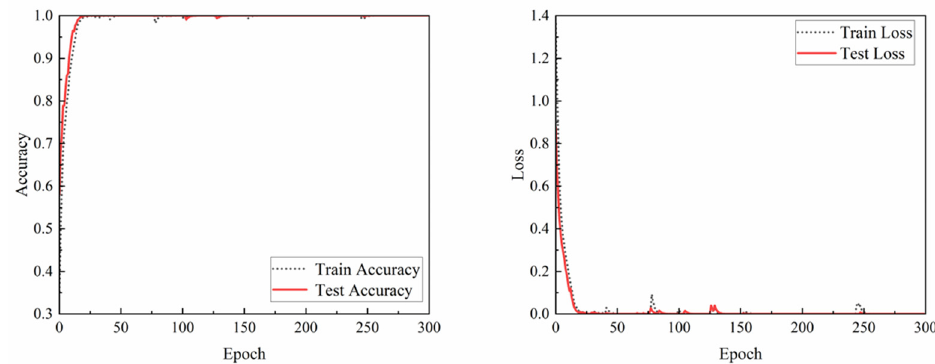
Figure 20. Comparison of accuracy change curve of test set before and after noise addition.